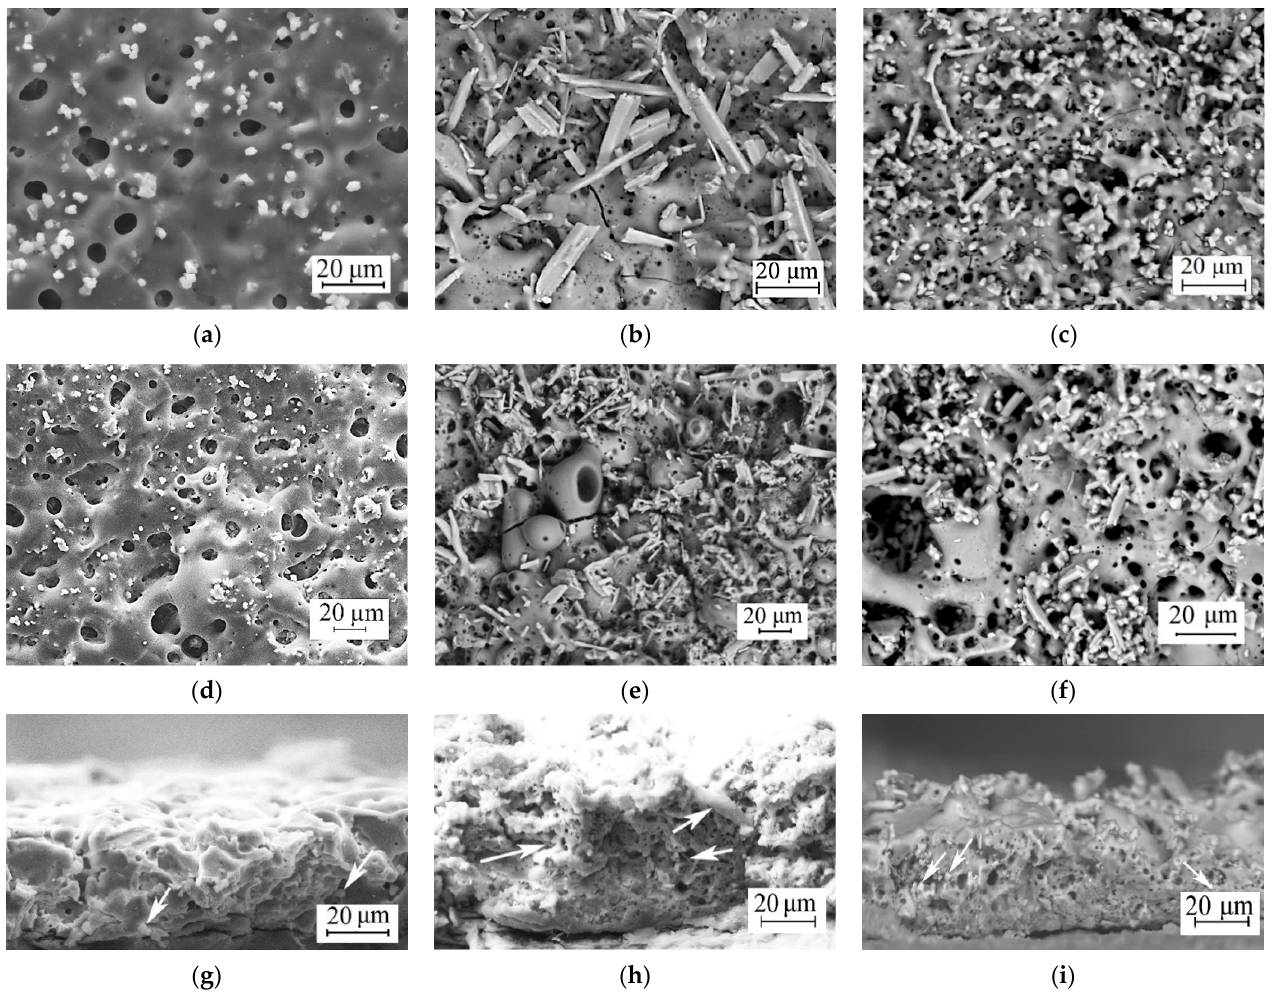
Figure 5. Surface morphology of the TC ( a , d ), WS ( b , e ), and TW ( c , f ) coatings, deposited at 350 ( a – c ) V and 500 V ( d – f ); cross-section images of the TC ( g ), WS ( h ), and TW ( i ) coatings, deposited at 400 V.